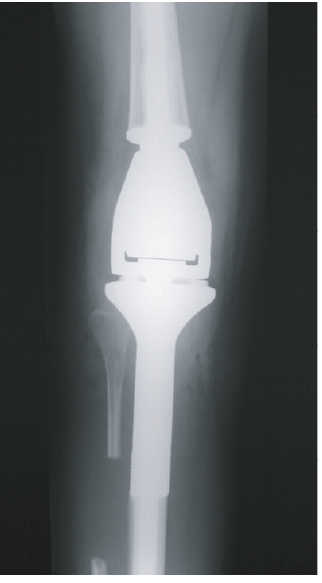
Figure 2: MRI right leg, showing osteosarcoma of proximal tibia with further lesions in the distal femur.